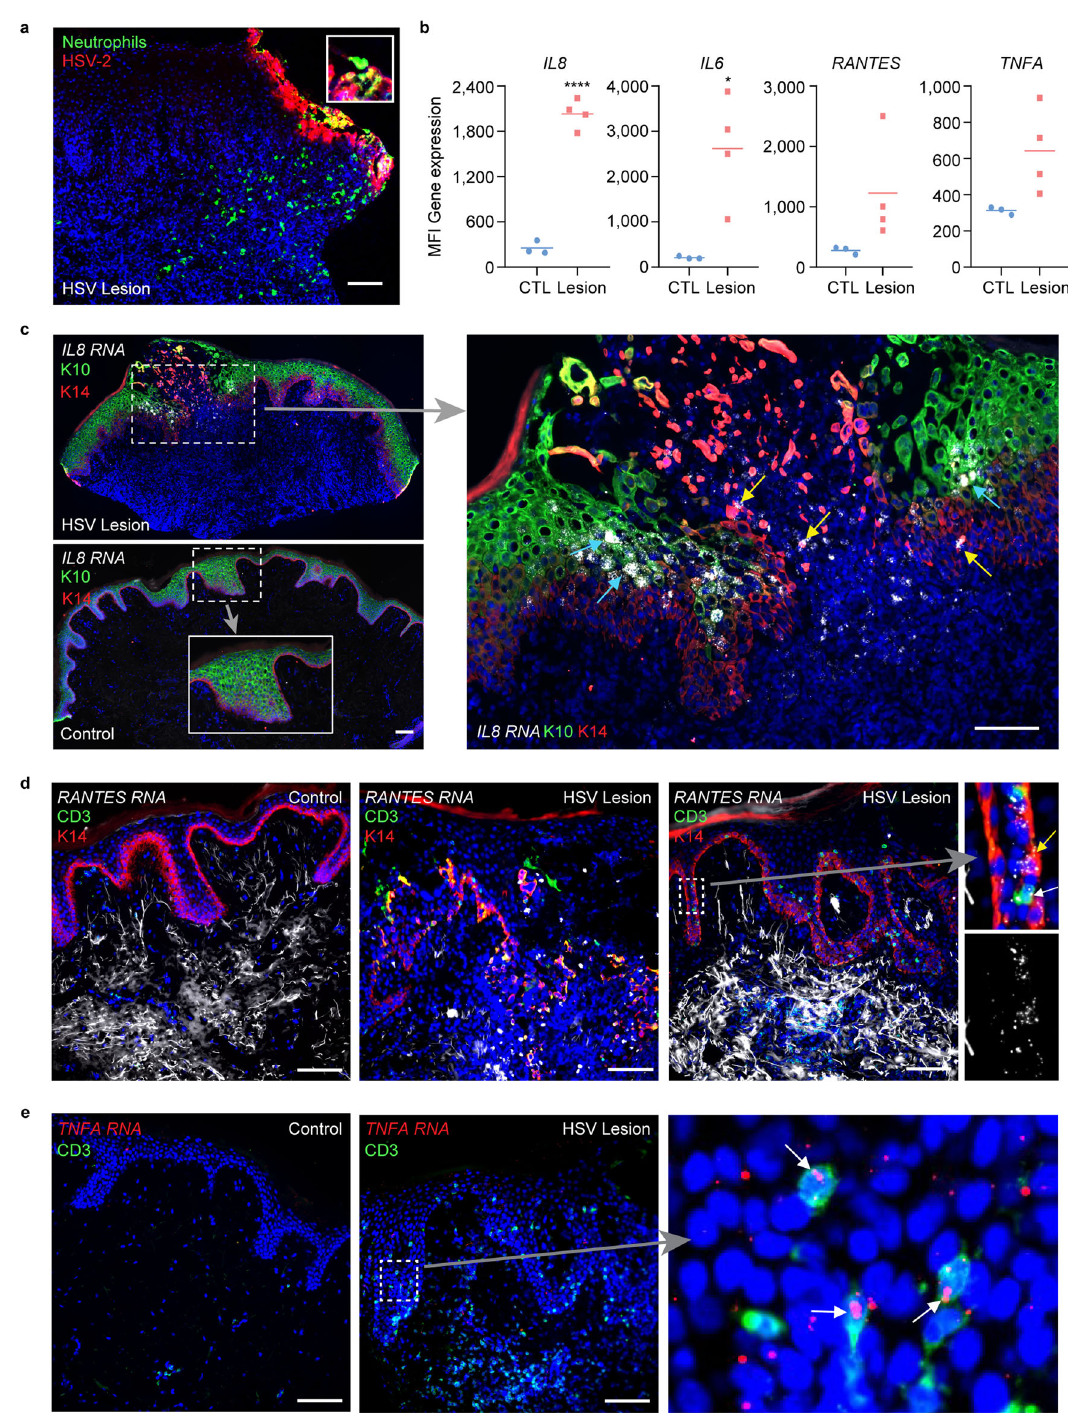
Fig. 6 | Neutrophil migration and cytokine expression in human genital HSV ulcers. a Neutrophil in fi ltration from dermis into HSV-infected epidermis in a human skin biopsy representative of an ulcerative herpes lesion. CD15 + neu- trophils (green), HSV (red). Scale bar: 100 µ m. b Transcriptional levels of IL8 , IL6 , RANTES , and TNFA in human skin biopsies obtained from sites of HSV ulcerative lesion ( n =4) or from uninvolved contralateral controls (CTL, n =3). Microarray data re-analyzed from a published data source 45 . * p =0.0185 *** p <0.0001 gen- erated with paired two-tailed t -test. c Detection of epidermal IL8 RNA transcripts using fl uorescencein situ hybridization (FISH) inhumanskin biopsies. HSVlesion (upper) and matched normal control at contralateral site (bottom). Enlarged